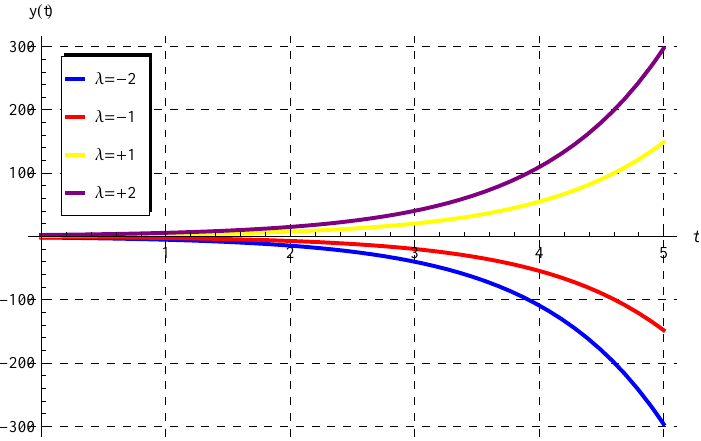
Figure 8. Plots of the approximate solutions φ m ( t ) , m = 1,2,3,4 in Equation (39) vs. t at λ = 1, c = 5, b = − 1, and a = − 5.